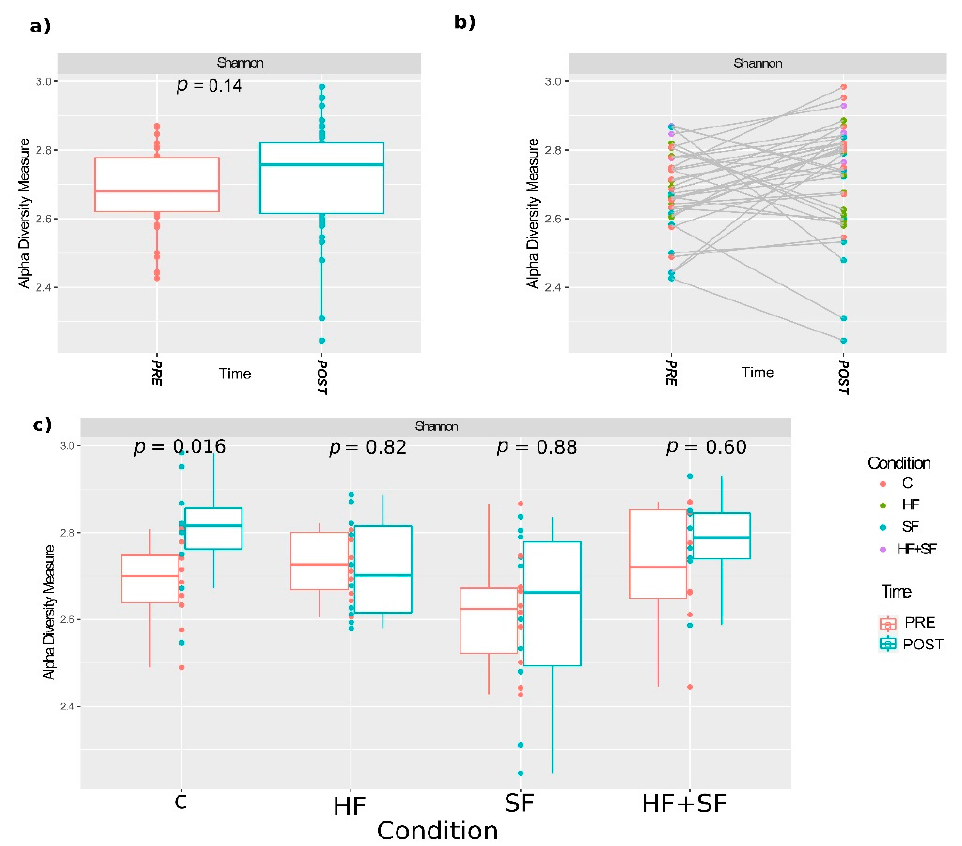
Figure 3. Shannon alpha diversity measure representation for the paired samples. ( a ) Shannon index according to the Time variable. Wilcoxon test p value is represented; ( b ) variation of Shannon diversity indexes before and after the experiment in each individual mouse. Samples are colored according to the experimental condition. ( c ) Shannon index according to the Condition variable (C: controls; HF: heart failure; SF: sleep fragmentation; HF + SF: heart failure and sleep fragmentation. Kruskal-Wallis test p values are represented.